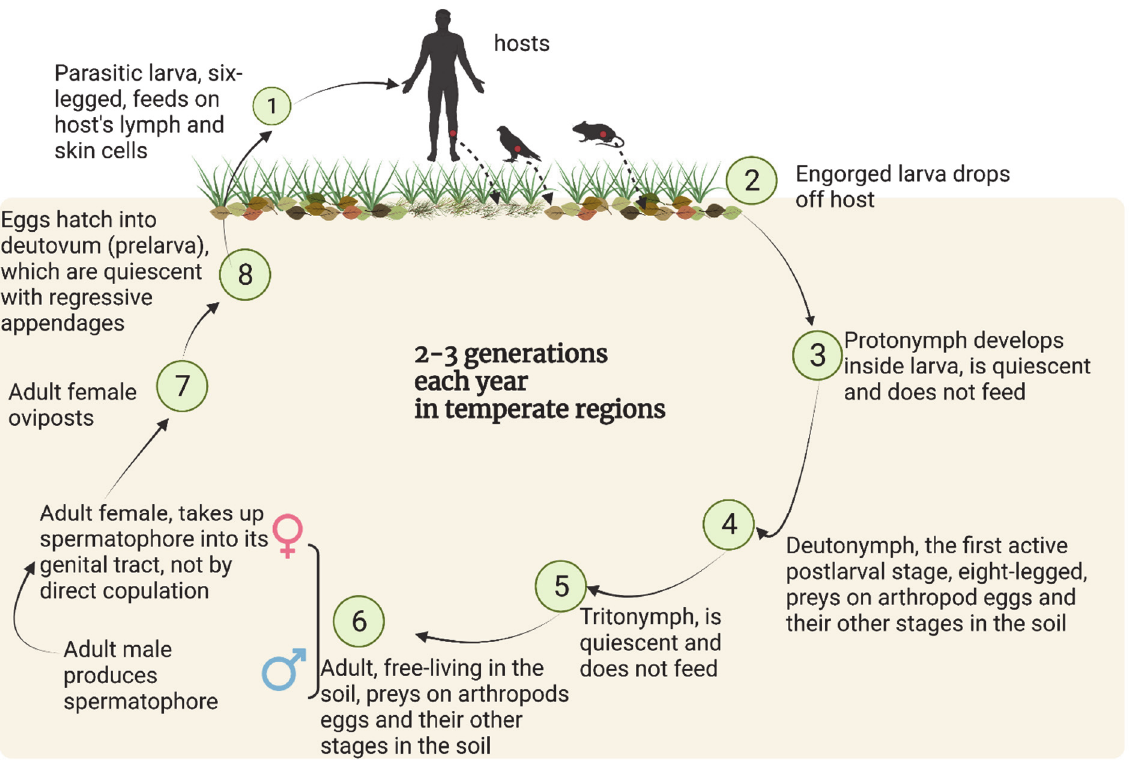
Figure 2. The typical life cycle of chiggers. Created with BioRender.com. Data sources: